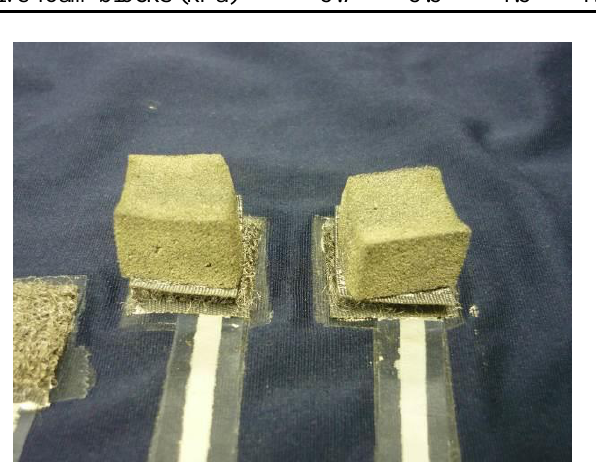
Figure 8. Conductive foam blocks on the smart